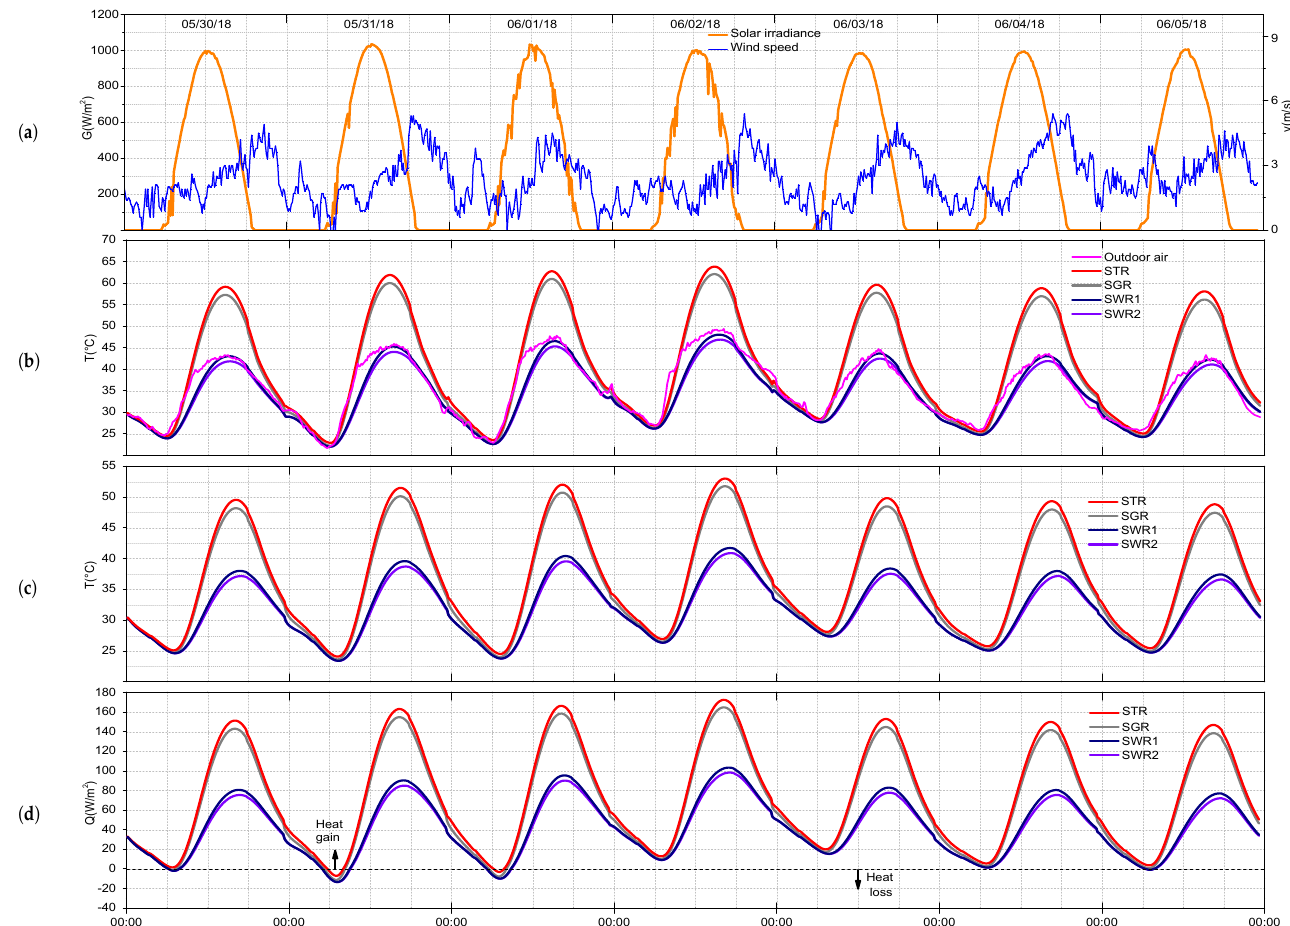
Figure 4. Thermal behavior of the single roof with traditional and solar reflective coatings in Hermosillo; ( a ) Solar irradiance and wind speed; ( b ) Temperature of exterior surface and outdoor air; ( c ) Temperature of interior surface; ( d ) Heat flux of the roofs.